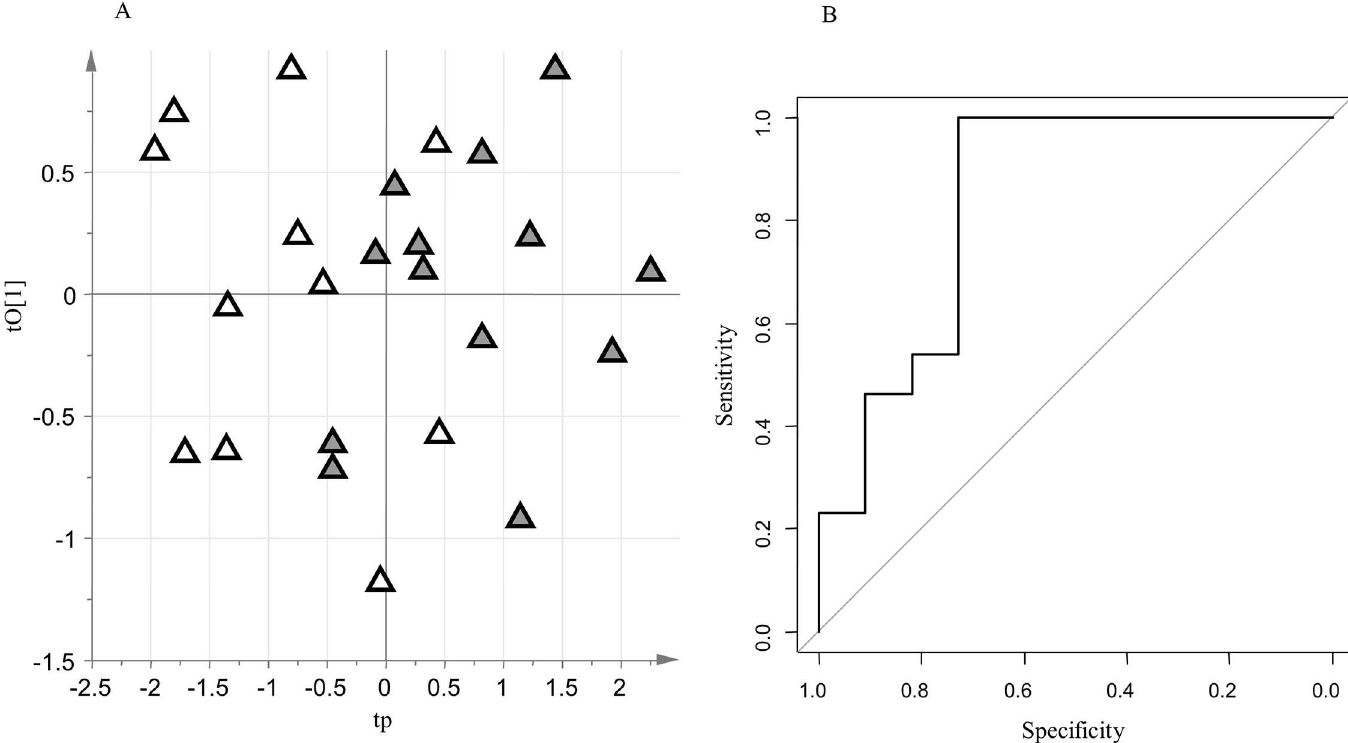
Fig 2. oCPLS2-DA model for PTD group versus TD group (negative data set); A: score scatter plot after post-transformation of the model (PTD are reported as grey triangles while TD as open triangles); B: ROC curve of the model, calculated by 7-folds full